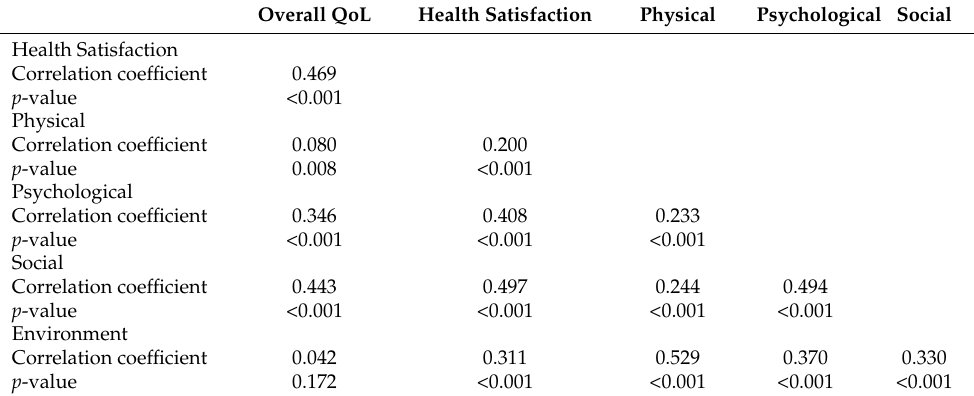
Table 4. The correlations between WHOQOL-BREF